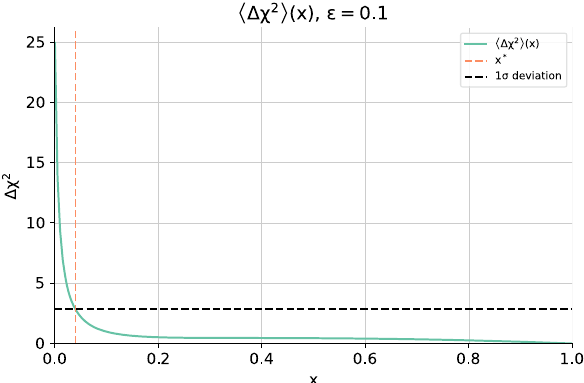
Fig. 2 Stability of the toy model with additional assumptions on the value of the correlation. The green curve shows the deviation in χ 2 averaged over the assumed prior of the x parameter, Eq. (39). The black dashedhorizontallinemarksthelimitfromthestabilitycriterionEq.(7). The orange dashed vertical line, in the intersection, shows the most likely value of x that fulfills the stability criterion, Eq.